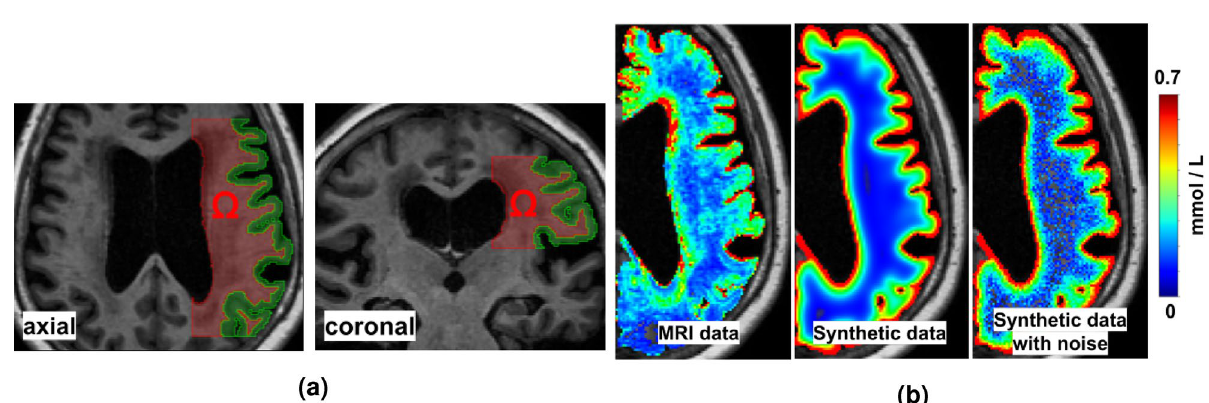
Figure 2. Geometries and data considered in this work. ( a ) Axial and coronal slices through the subregion (cid:31) of the white matter we consider in this work. The green region depicts the gray matter and is drawn to illustrate the geometrical complexity of the grey matter. ( b ) Axial view of the tracer concentration after 24 h in the right hemisphere for the three data sets under consideration. Note how the tracer enters the brain from CSF spaces